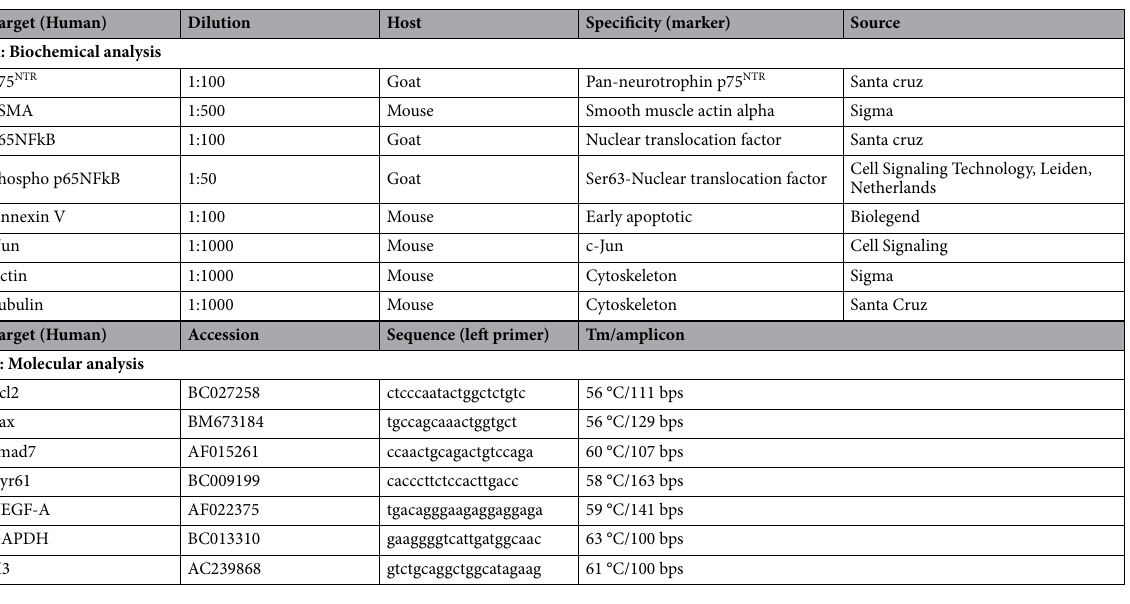
Table 1. Antibodies and primers overview. (A) primary antibodies used for western and immunofluorescence assay. (B) Summary of name, for/rev sequence (5 ′ to 3 ′ ), PCR product size (amplicons in bps), annealing conditions and GenBank Accession Numbers of each gene investigated. Amplification profile: hot start activation (95 °C/15 min); 39 cycles: den. at 94 °C/10 s—ann. At 58 °C/15 s—ext. at 72 °C/10 s; melting